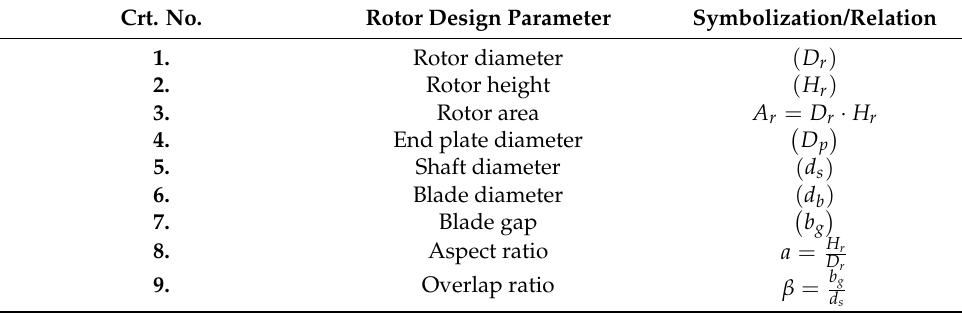
Table 1. Design parameters for the vertical-axis wind turbine rotor [61–65]. Crt. No.